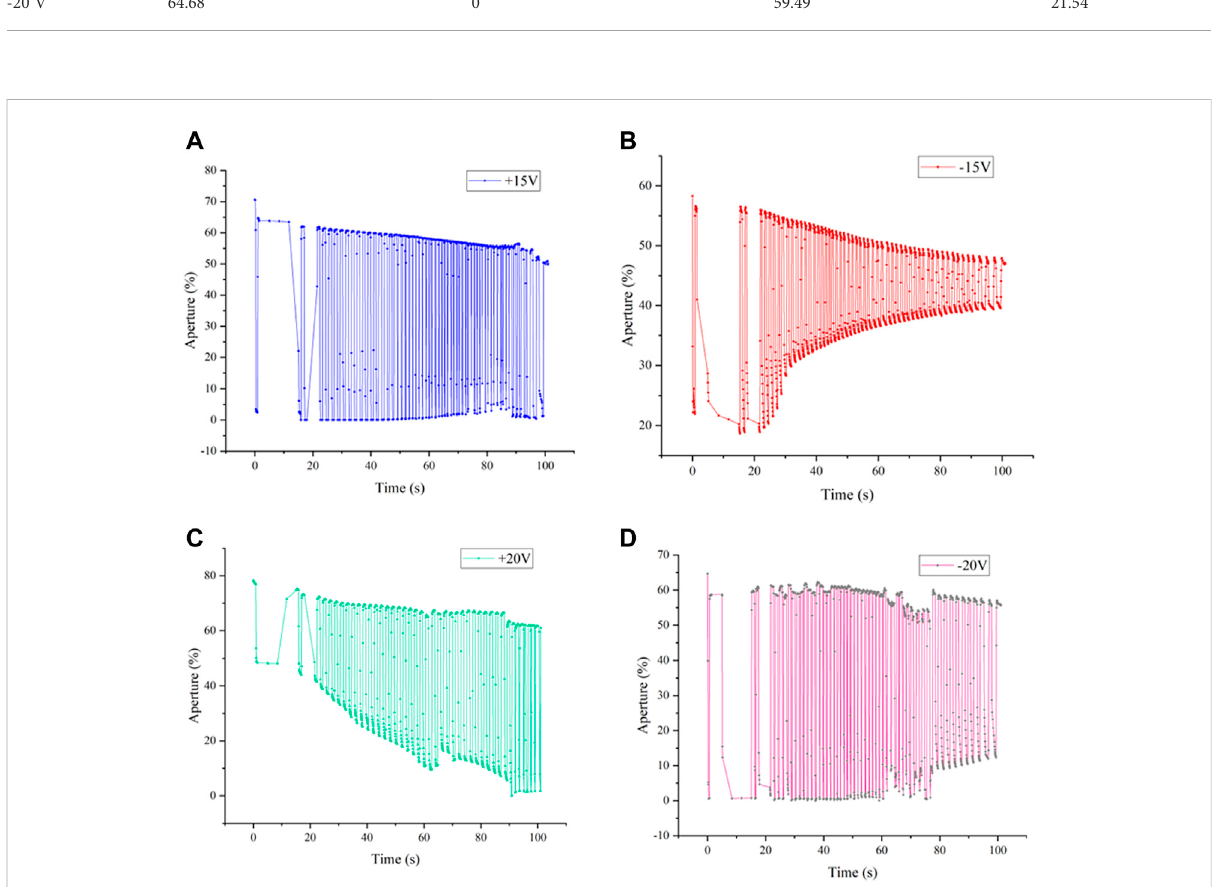
FIGURE 8 ApertureratiowithDCdriving. (A) Apertureratiowith+15 VDCdriving. (B) Apertureratiowith-15 VDCdriving. (C) Apertureratiowith+20 VDC driving. (D) Aperture ratio with -20 V DC